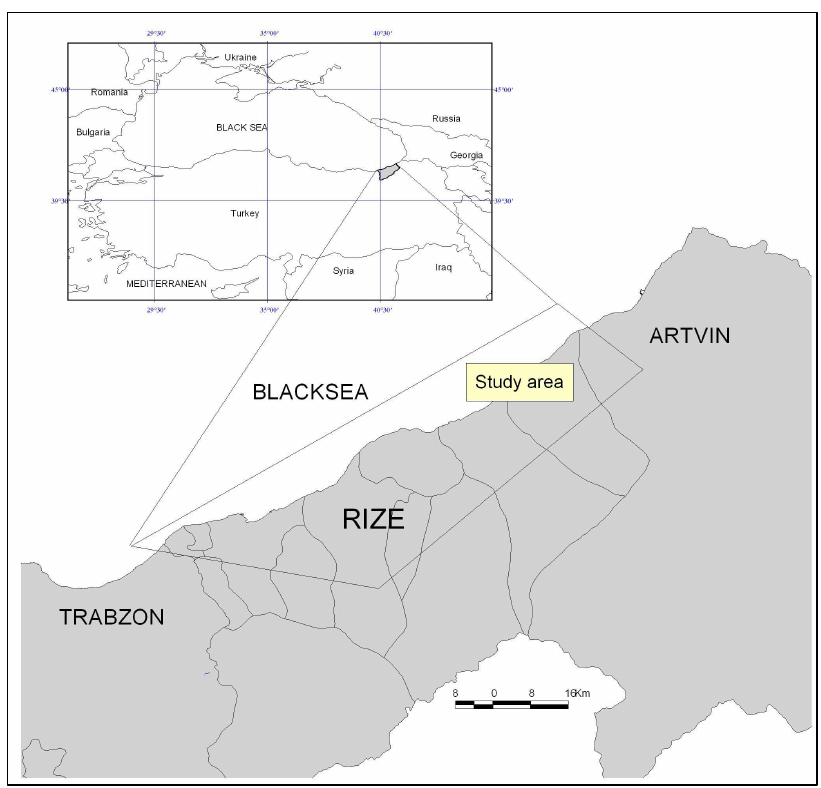
Figure 1 . Location of the study